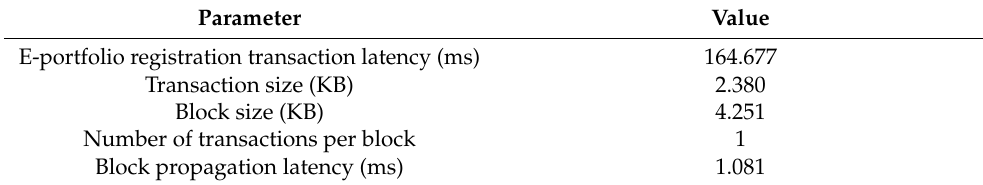
Figure 7. Transaction latency and throughput: ( a ) e ‐ portfolio registration transaction latency meas ‐ urements with variable input transaction rates; ( b ) e ‐ portfolio registration and e ‐ certificate issuance transaction throughput measurements with variable input transaction rates. Table 7. E ‐ portfolio registration transaction performance. Table 7. E-portfolio registration transaction performance.